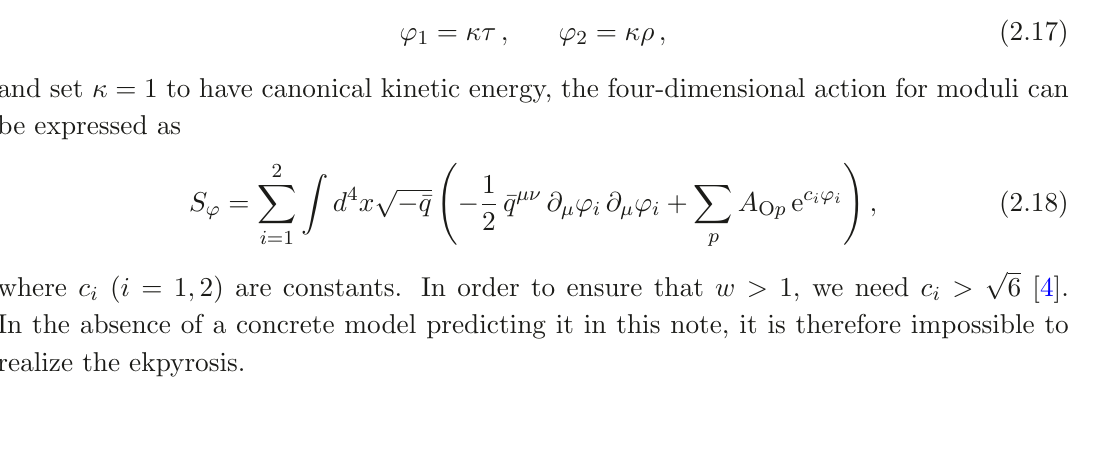
d p − 3 x √ g p − 3 = 1 , ( p = 3 , 5 , 7 , 9), R